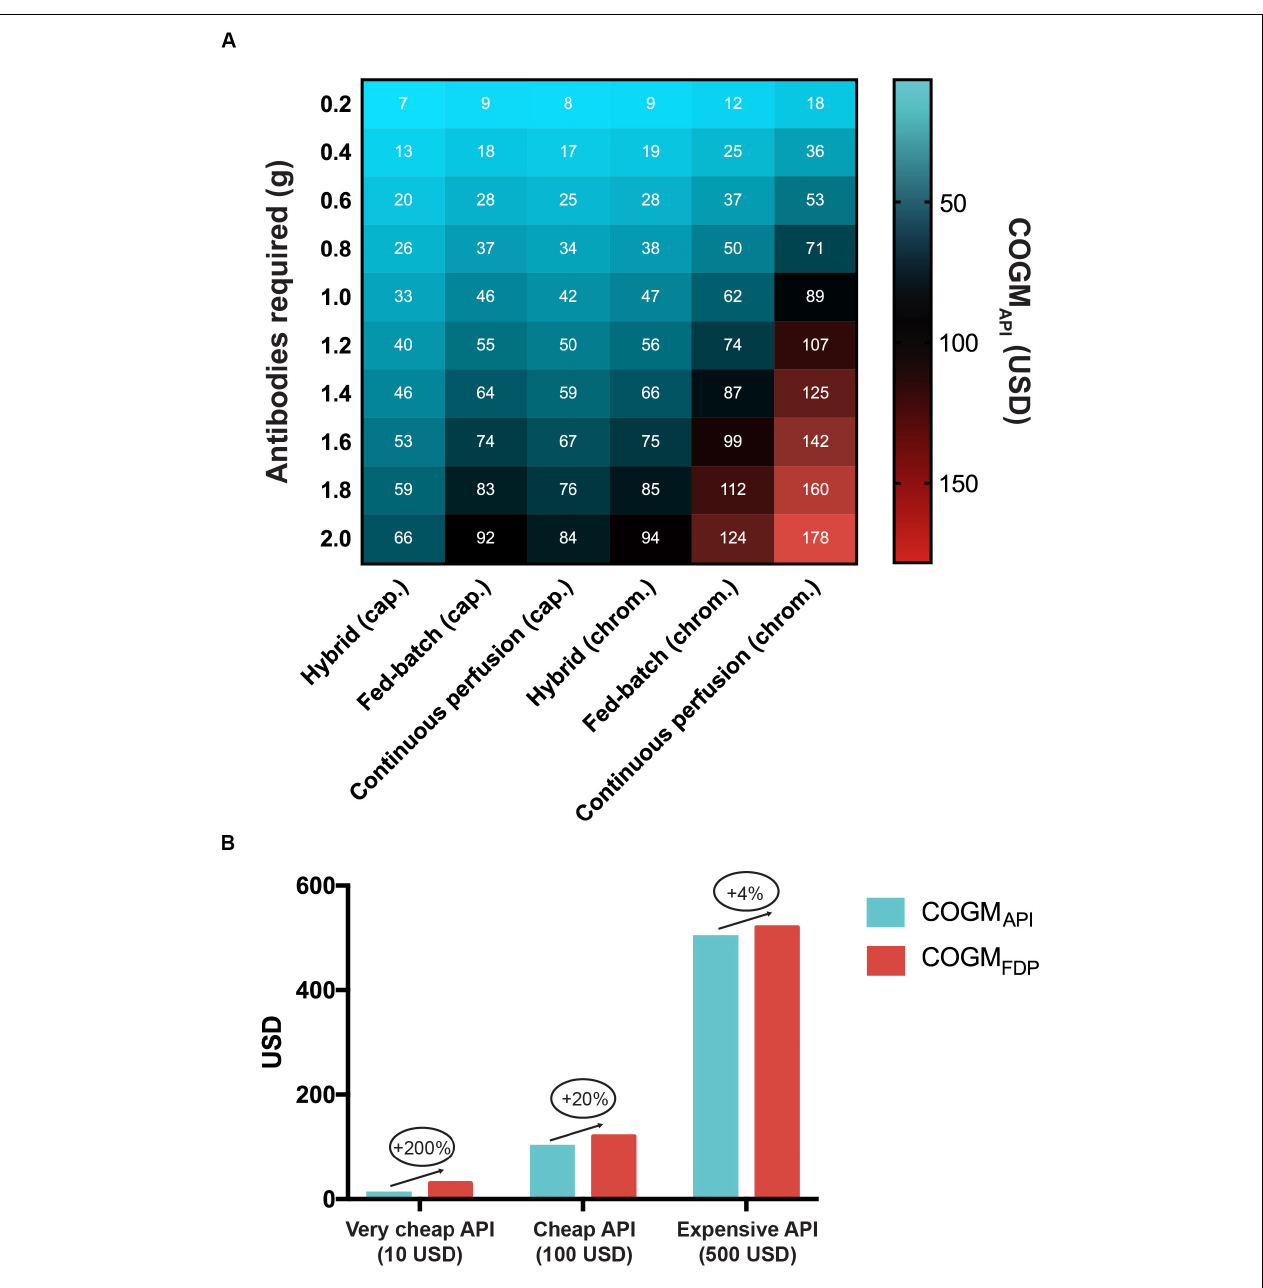
FIGURE 2 | Cost of manufacture for recombinant antivenoms in relation to manufacturing process and treatment dose. (A) Cost impact of different manufacturing strategies in relation to how many grams of antibodies are required for a full antivenom treatment of a snakebite envenoming case. The three upstream processes included are the fed-batch process, the hybrid process, and the continuous perfusion process. Each upstream process was combined with either chromatographic or caprylic acid purification steps to calculate the respective Cost of Goods Manufactured of the Active Pharmaceutical Ingredient (COGM API ) per treatment. The white numbers in the cells correspond to the exact COGM API corresponding to that particular cell. (B) The impact of formulation on the final drug product (FDP) cost for very cheap, cheap, and expensive COGM API